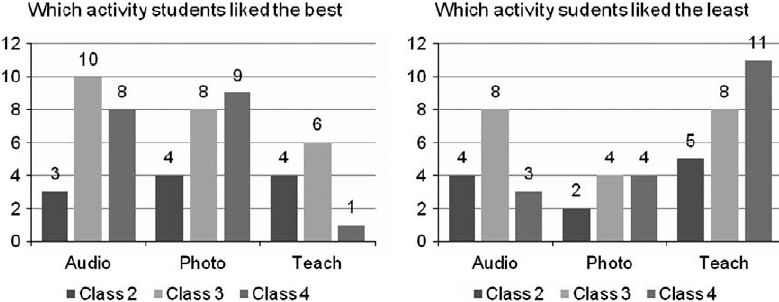
Figure 5. The students’ most liked (left) and least liked (right) activity for each